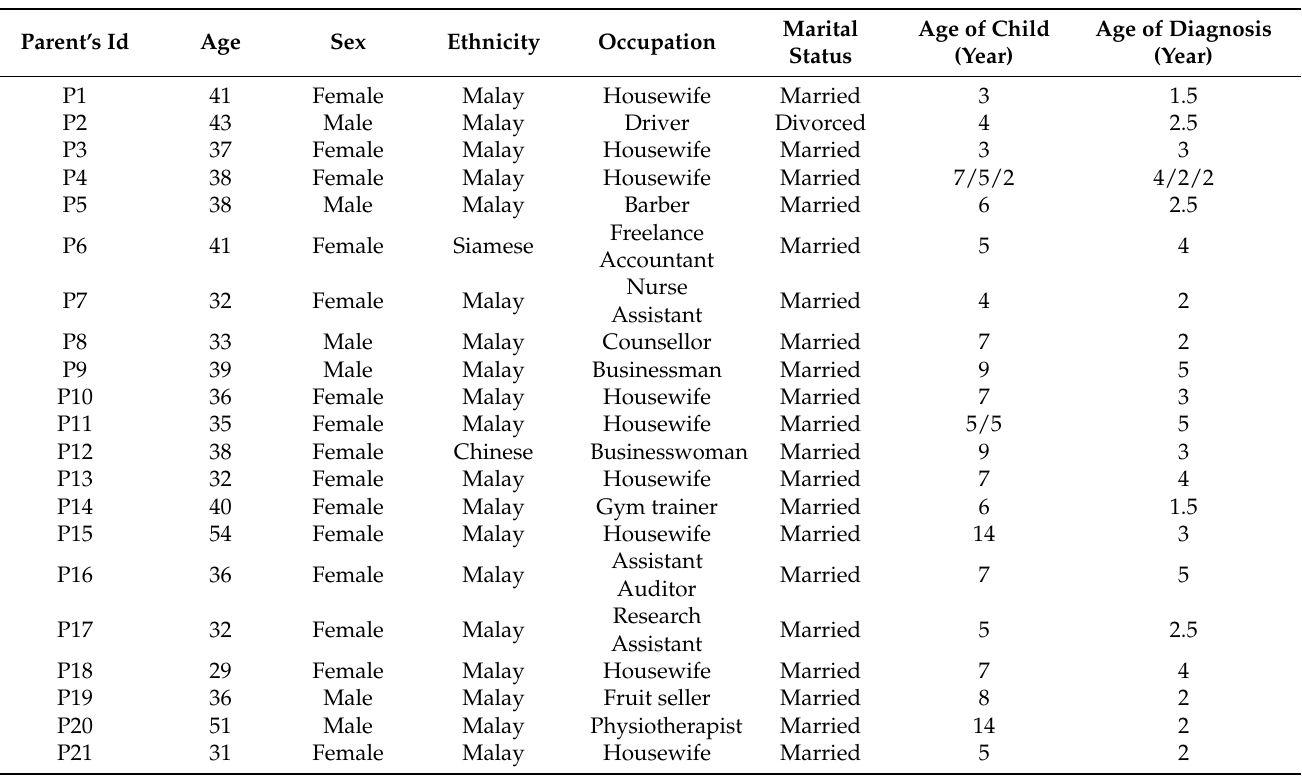
Table 1. Socio-demographics of parents with ASD children ( n = 21).